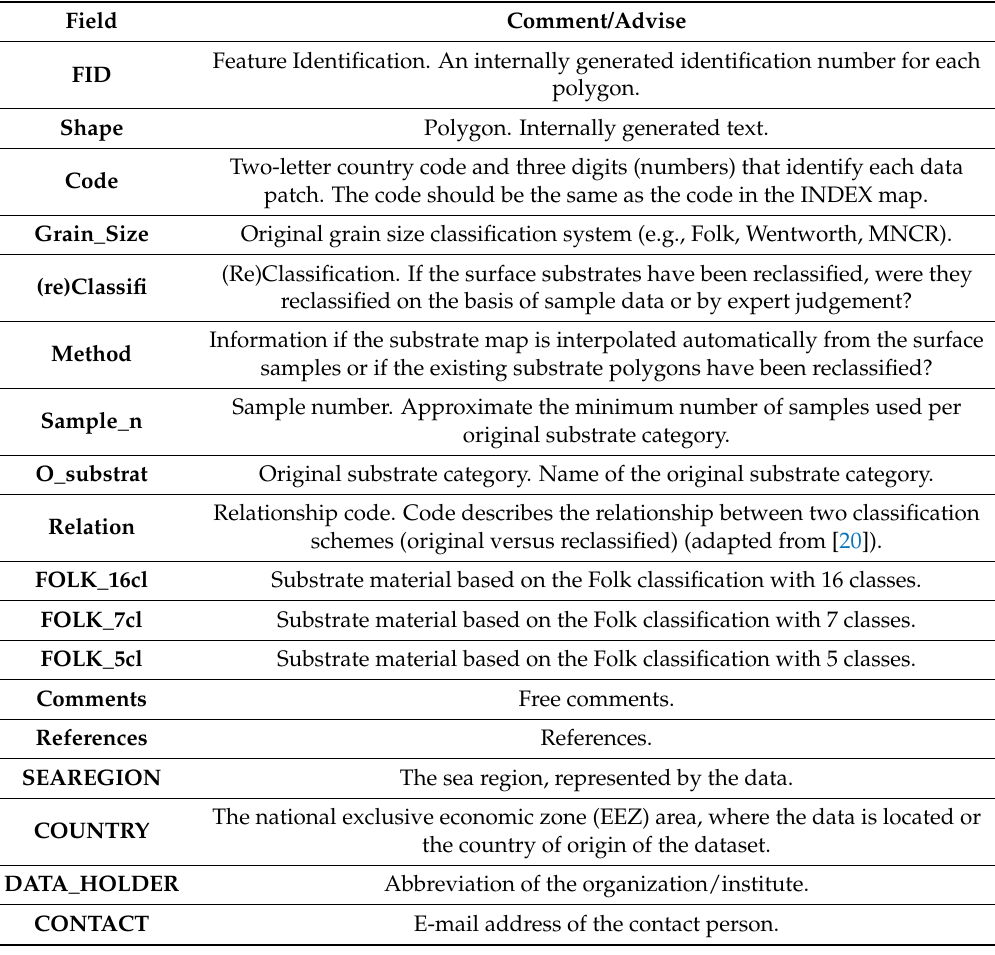
Table 2. Seabed substrate attribute table with 14 columns describing the